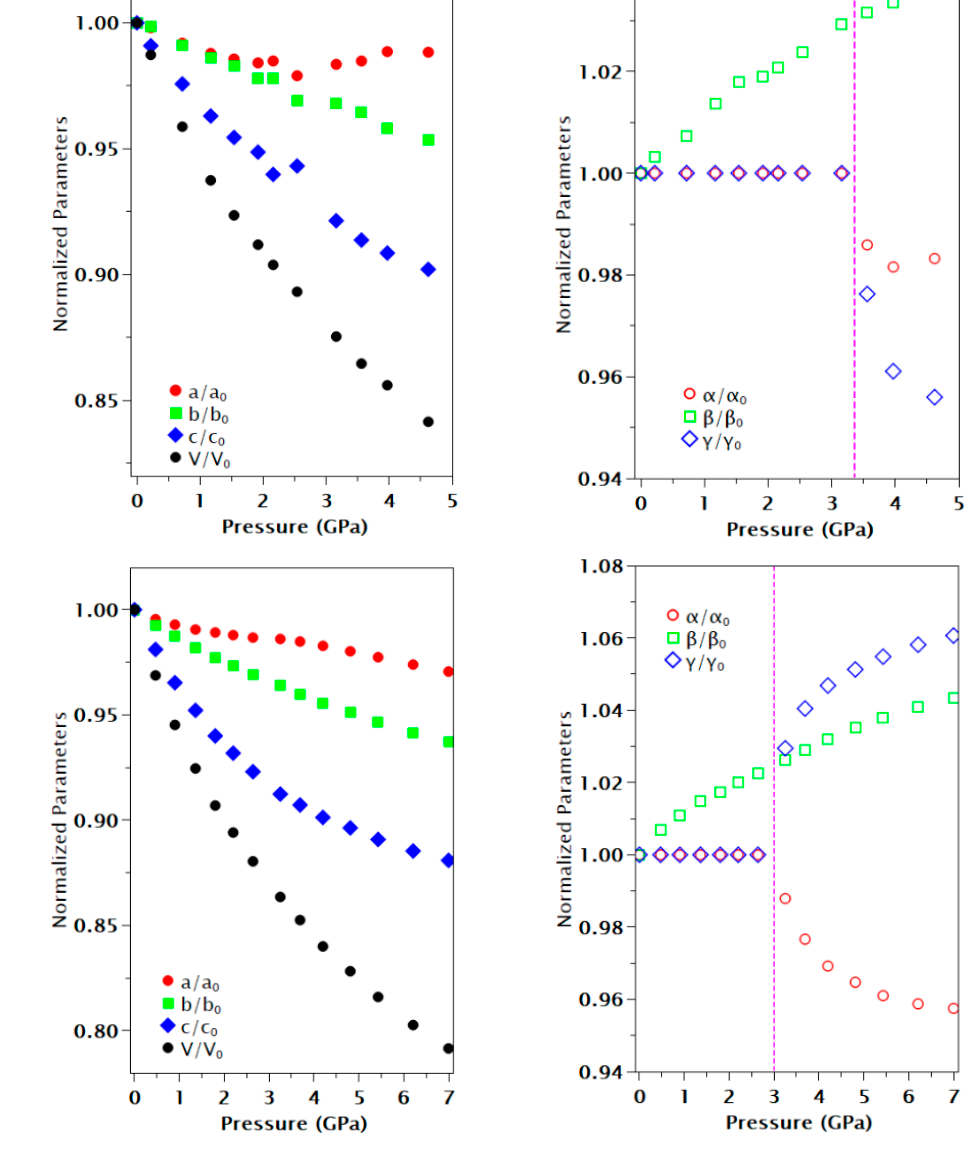
Figure 3. Pressure dependence of the cell parameters and volume for [(CuBr) 2 (Quin)] ( top ) and [(CuI) 2 (Quin)] ( bottom ). The dashed magenta line marks the phase transition zone. Error bars are smaller than their respective symbols.